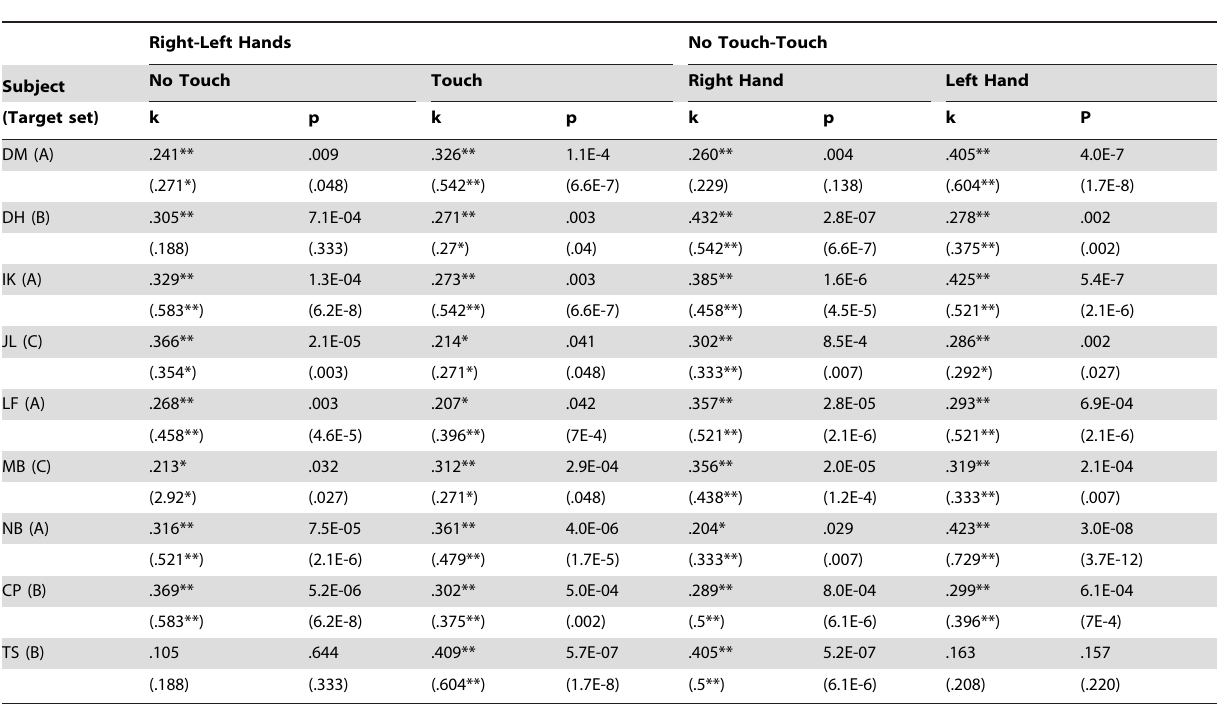
Table 1. Test of Similarity Across Hands and Conditions: Resulting k and p-values from the K-S test.